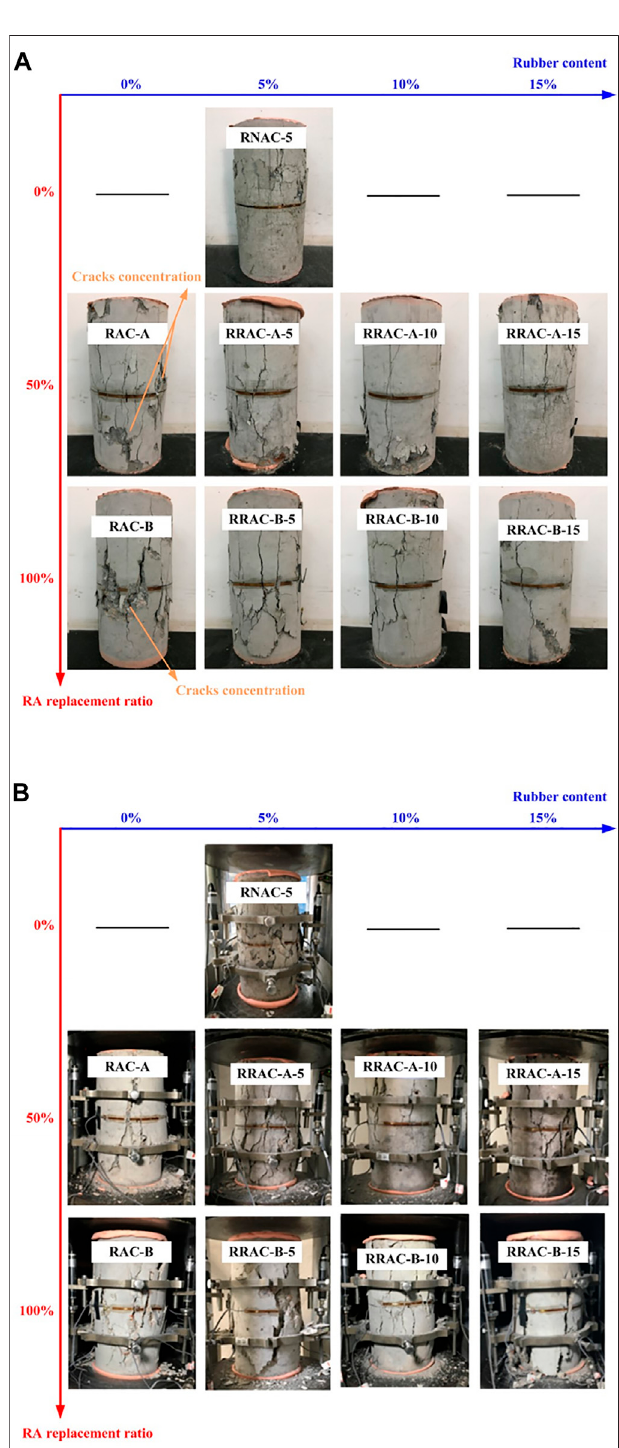
FIGURE 5 | Failure modes: (A) Without heating treatment; (B) After 600 ° C heating